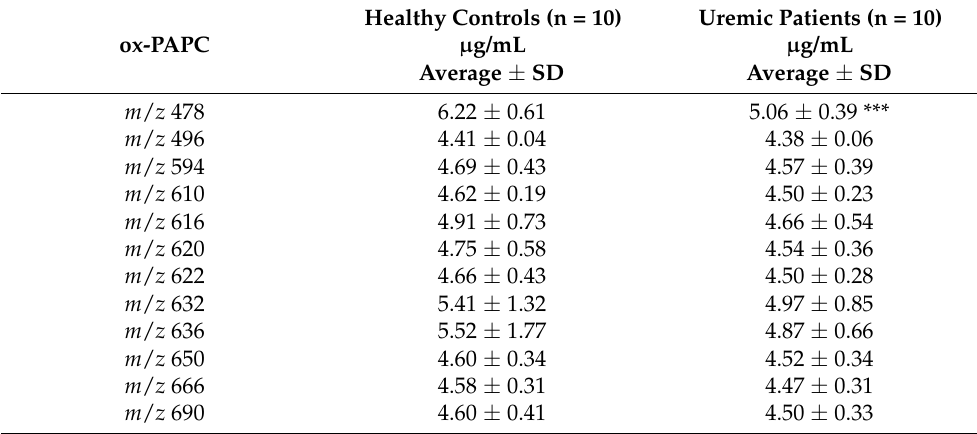
Table 4. Short-chain ox-PAPC product concentrations in LDL of healthy controls and uremic patients.